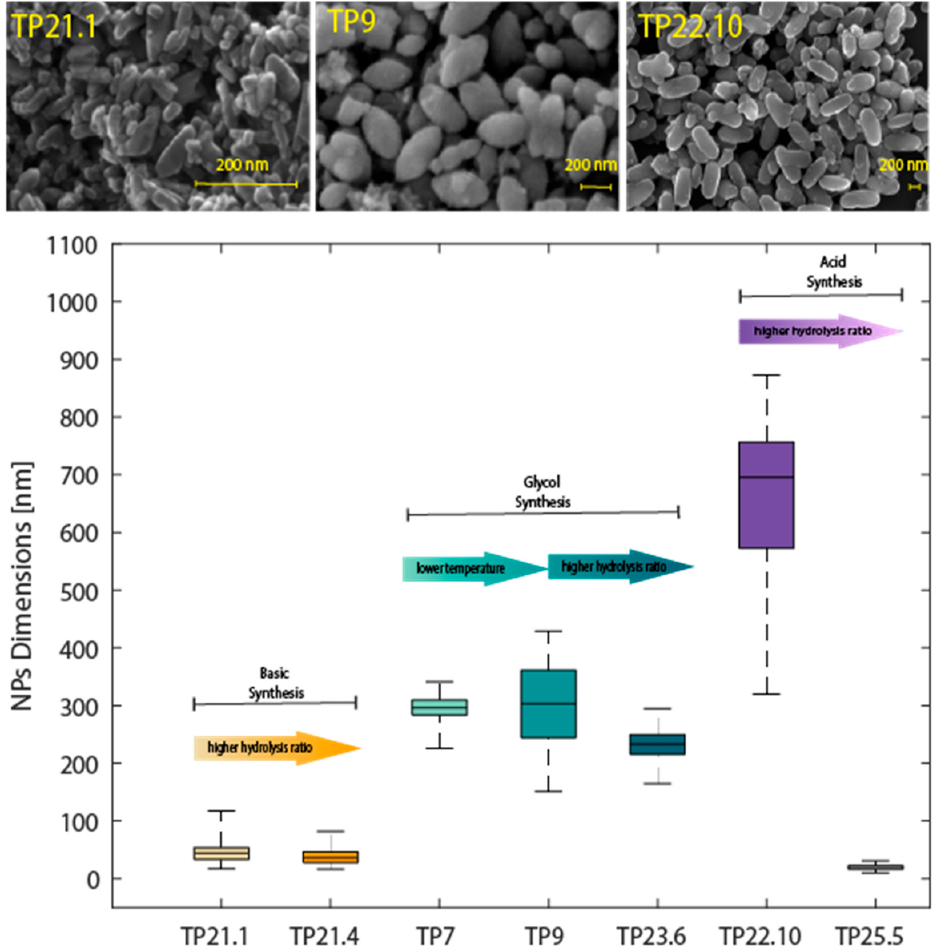
Figure 14. Diagram correlating the different syntheses and the NP dimensions. The morphology of some samples is also reported.